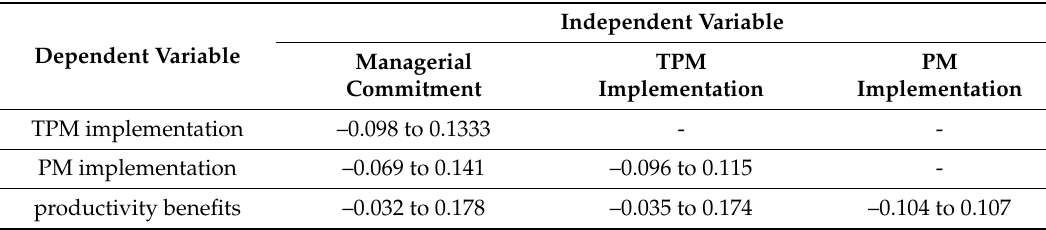
Table 12. Confidence intervals for differences in β